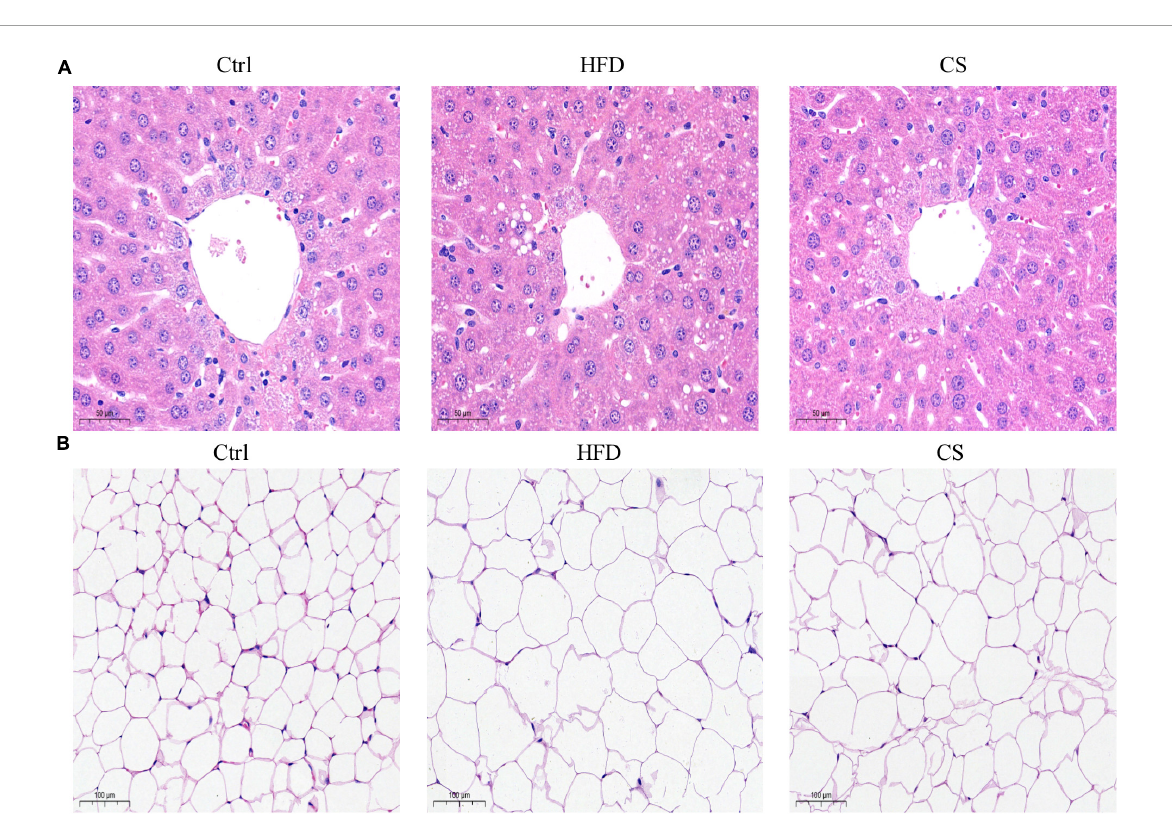
FIGURE3 Effect of corn silk extract on histopathology of liver and adipose in mice. (A) Representative photomicrographs of hematoxylin and eosin-stained sections of the liver (400 × original magnification), (B) representative photomicrographs of hematoxylin and eosin-stained sections of the adipose (200 × original magnification). Control diet (Ctrl) group, high- fat diet (HFD) group, corn silk (CS)